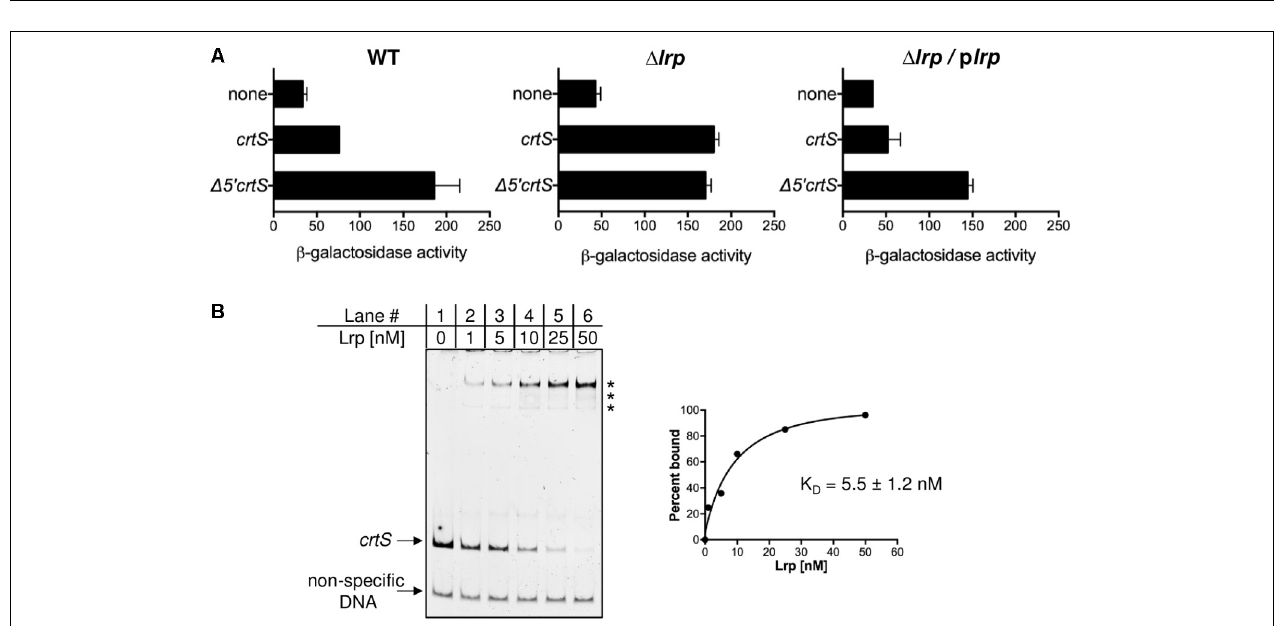
FIGURE 3 | P crtS is repressed by the global regulator Lrp. (A) Promoter activity was measured after fusion to lacZ in WT (DH10- β ), in (cid:49) lrp (CVC3259) which is otherwise isogenic, and the same (cid:49) lrp strain complemented with p lrp (CVC3259/pPC401). The crtS fragments were the same as in Figure 2 . The deletion of lrp results in promoter de-repression, which is complemented in the presence of p lrp when crtS was full length and not when it was (cid:49) 5 (cid:48) . Error bars denote standard error of mean from two biological replicates. (B) Electrophoretic mobility shift assay (EMSA) of fluorescently labeled non-specific DNA (bottom arrow) and crtS DNA (top arrow) in the presence of increasing concentrations Lrp protein. Asterisks indicate positions of Lrp bound species. The fraction of the probe bound (quantified from the loss of intensity of the unbound probe) was plotted as a function of Lrp concentration to generate the binding isotherm that yielded an apparent dissociation constant (K D ) of 5.5 ± 1.2